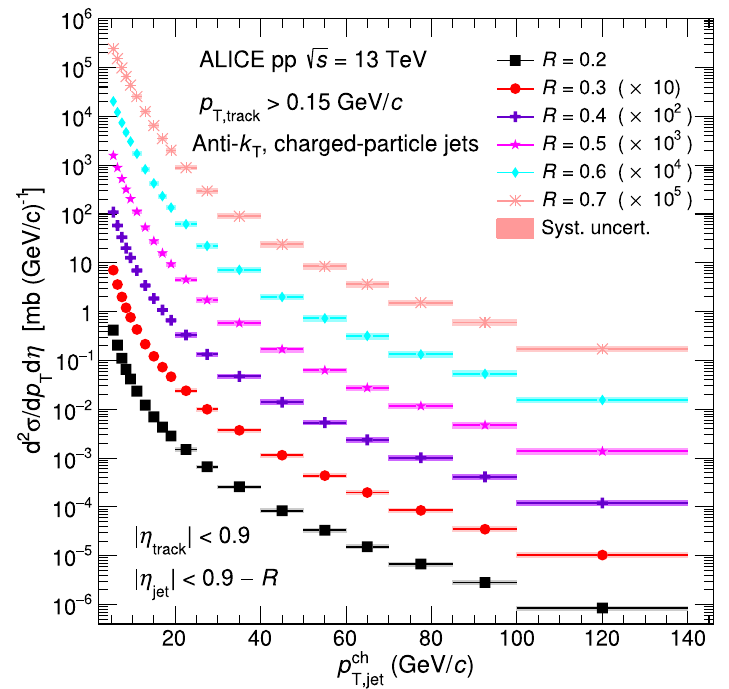
Fig. 15 Inclusive charged-particle jet cross sections in pp collisions √ s = 13 TeV using the anti- k T algorithm for different resolution at parameters R varied from 0 . 2 to 0 . 7, without UE subtraction.